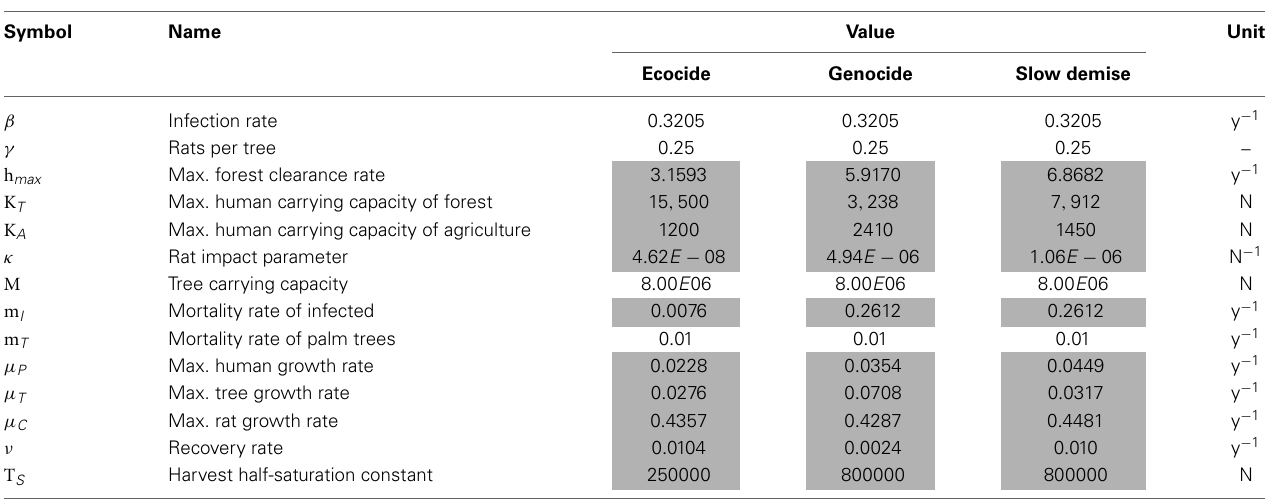
Table 1 | Parameter